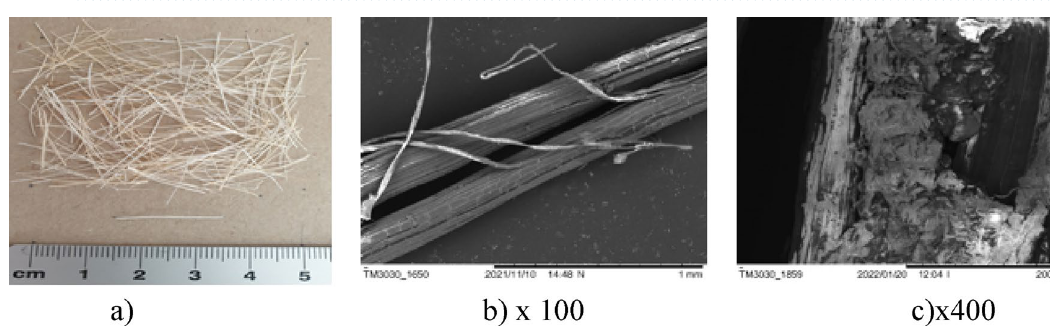
Figure 7. SEM of bamboo fibre [Fot.M.Kurpińska].